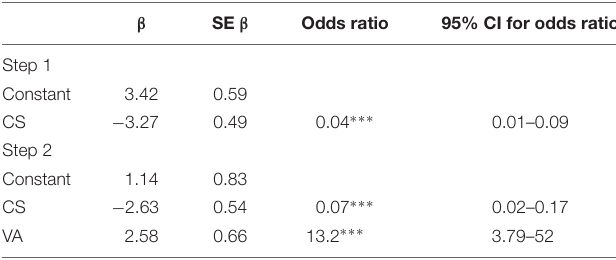
TABLE 2 | Stepwise logistic regression examining the ability of contrast sensitivity (CS) and visual acuity (VA) to predict ‘below expected’ shooting